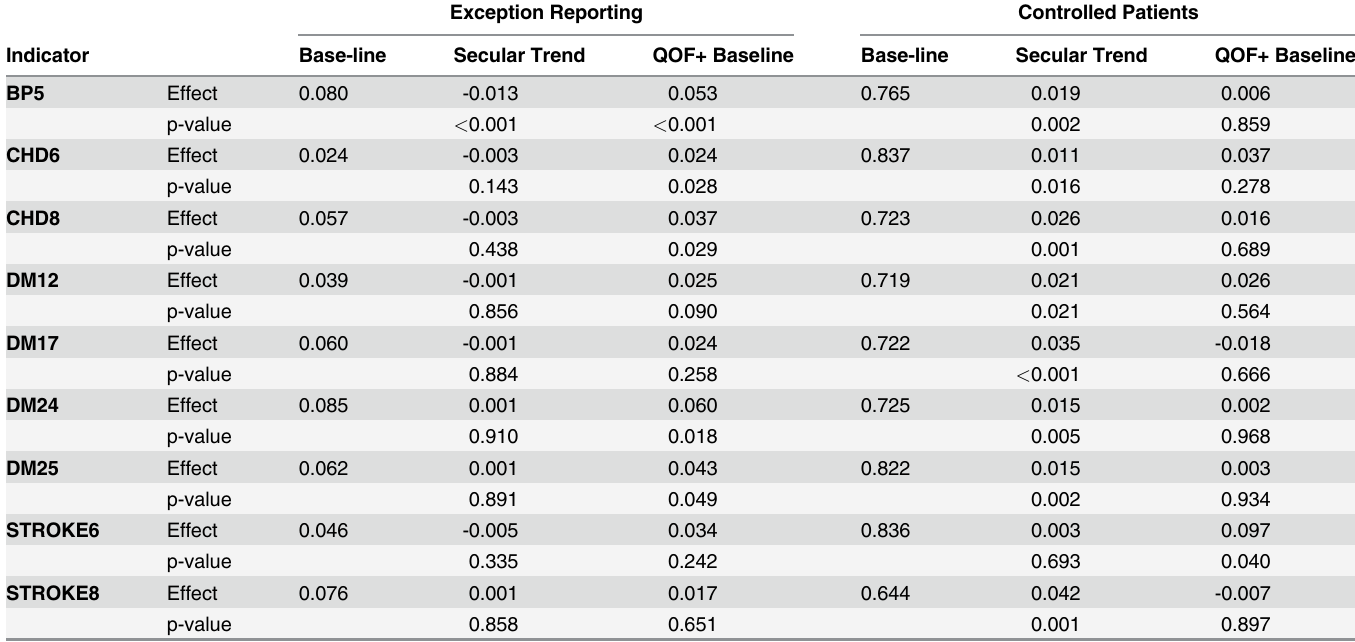
Table 4. Change in the fraction of exception reported and controlled patients relative to all patients in the corresponding disease group upon intro- duction of QOF+.